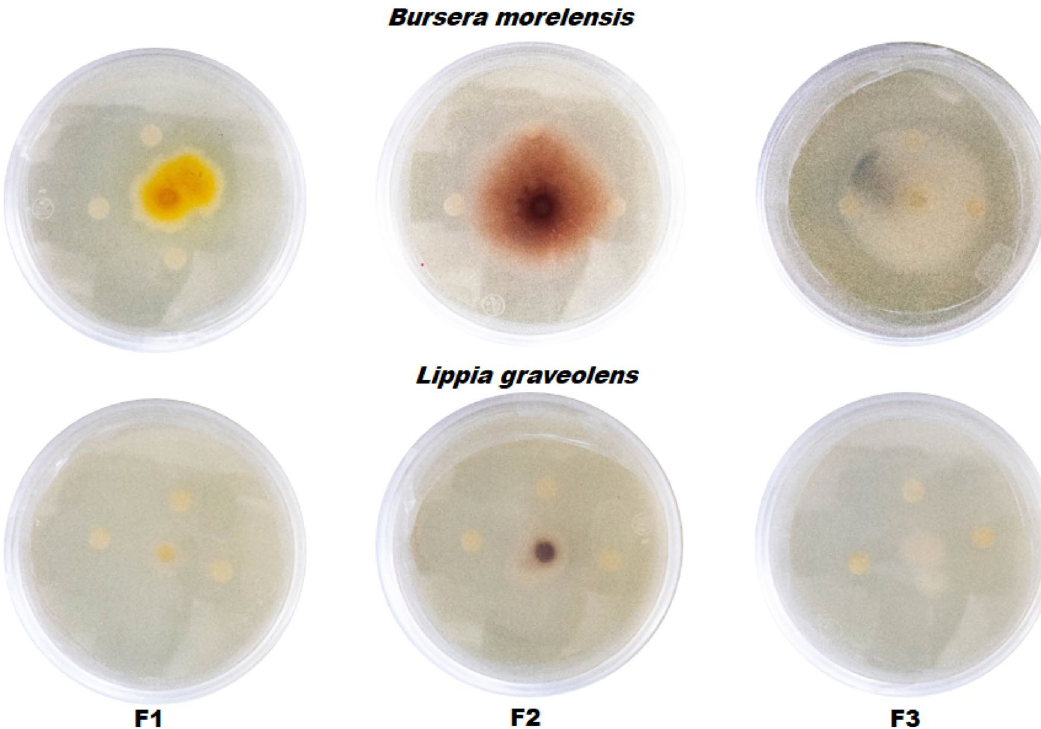
Figure 1. Effect of essential oils on the growth of three Fusarium strains in an in vitro model. Inhibition of radial growth of Fusarium sporotrichioides (F1), Fusarium moniliforme (F2), and Fusarium solani (F3) exposed to Bursera morelensis and Lippia graveolens essential oils.